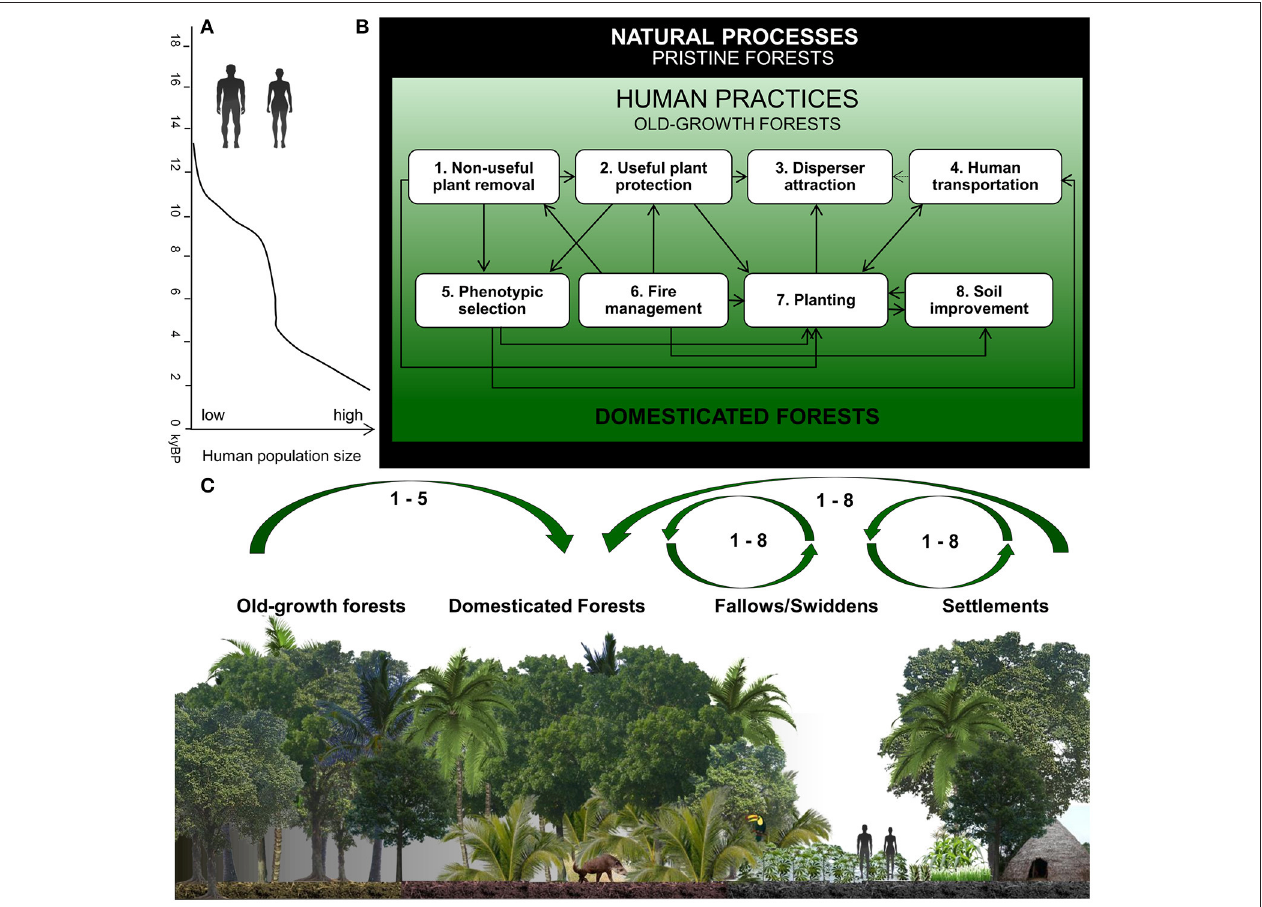
FIGURE 1 | Conceptual model illustrating the interaction of eight management practices and their effects on the domestication of forests through time. (A) Expected trends in human population growth rate in Amazonia from fourteen to two thousand years ago before present (kyBP) based on published data for South America outside of Amazonia (adapted from Goldberg et al., 2016). (B) Management practices (1–8), their interactions and their effects on the forest domestication process through time [from top (16 kyBP) to bottom (0 kyBP)]. Natural ecological processes operate during all moments in time and along a domestication gradient from pristine to domesticated forests. Management practices may have a positive direct effect (dark arrows) or hypothetical positive effect (light arrow) on other practices that intensify as human population increases (from light green to dark green). (C) The forest domestication process in a spatial context of human influence from settlements, through swiddens, domesticated forests to old-growth forests, which may have been domesticated in the past, but lack recent human intervention. Domesticated forests can originate (arrows) from settlements and swiddens, or from old-growth forests. Our model describes an open-ended